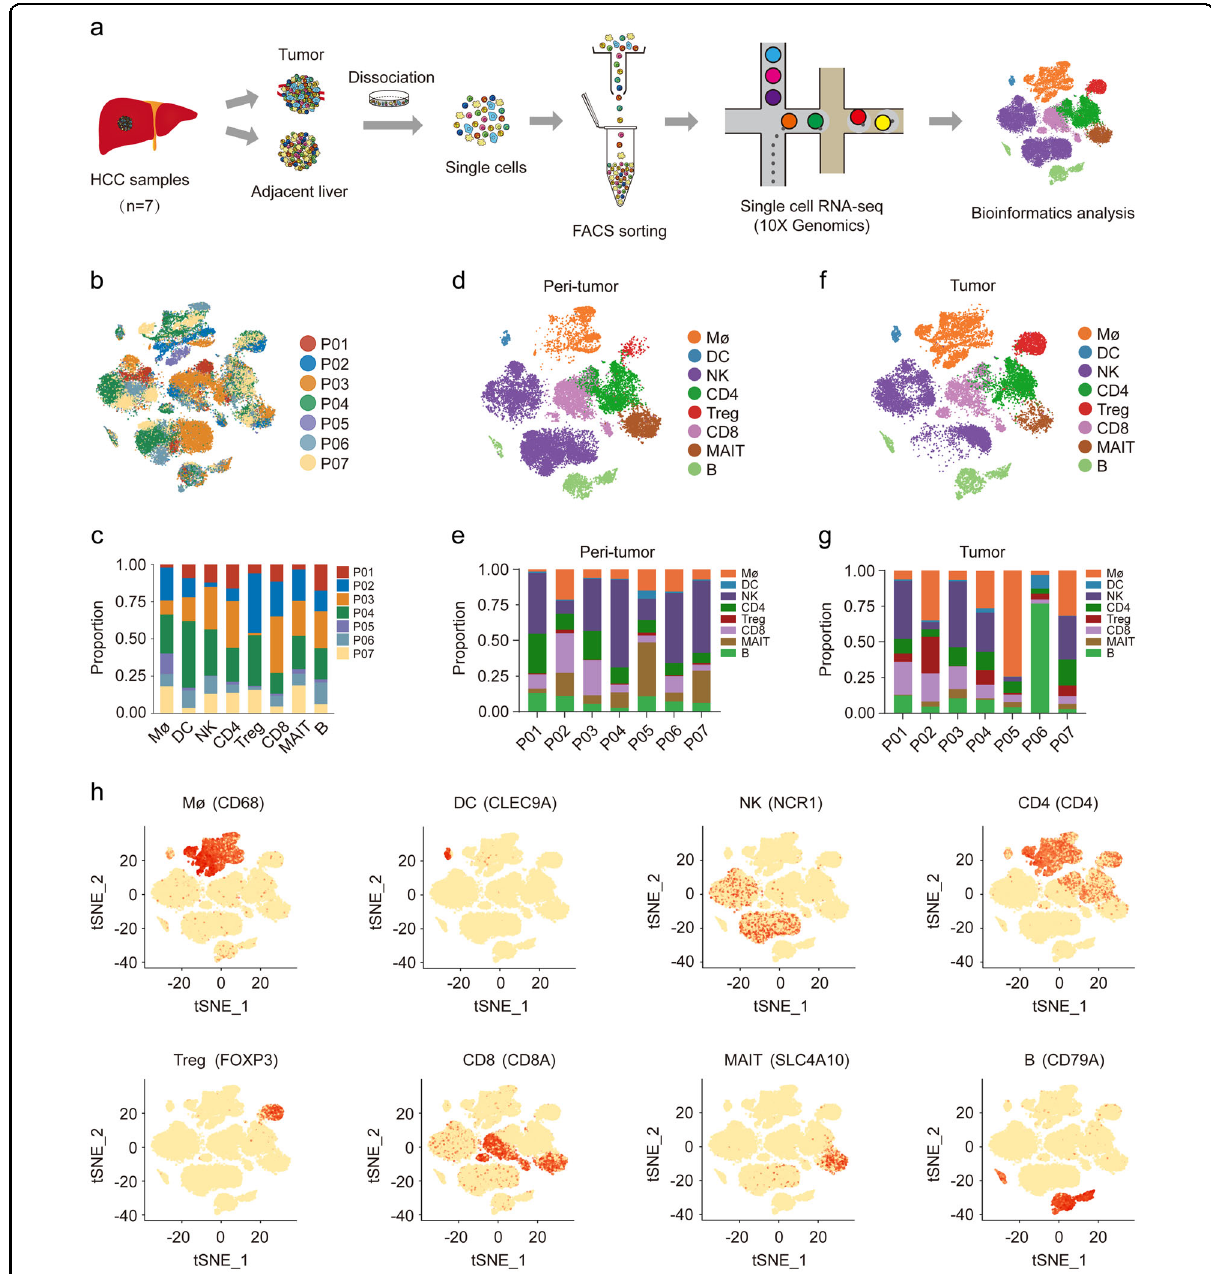
Fig. 1 Single-Cell Pro fi ling of diverse immune cells from HCC tumors and distal peri-tumors. a Overview of the study work fl ow. b , c t-SNE plot and proportions of all 41,698 cells annotated by the seven patients. d , e t-SNE plot and proportions of cell types vary across sample origin from peri- tumor tissues. f , g t-SNE plot and proportions of cell types vary across sample origin from HCC tumor. h Expression of cell-type-speci fi c marker genes illustrated in t-SNE